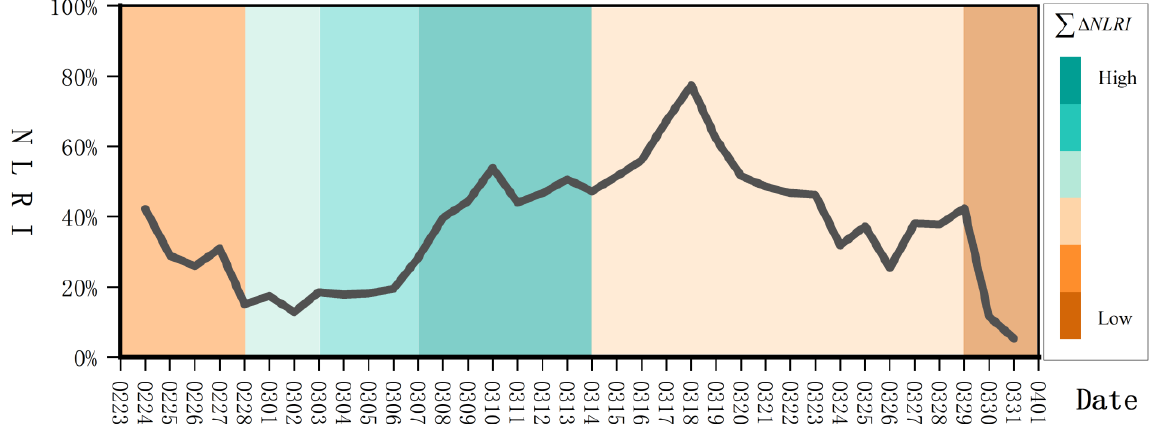
Figure 4. Ukraine’s night-time light ratio index from 23 February to 1 Figure 4. Ukraine ’ s night-time light ratio index from 23 February to 1 April.